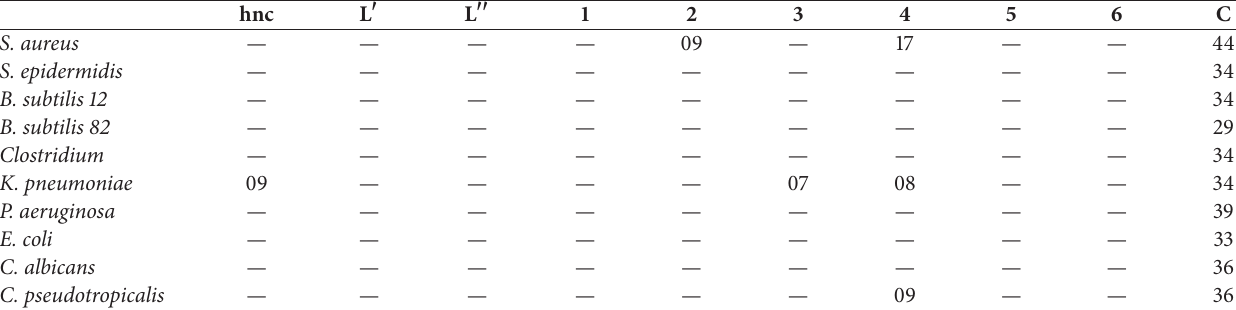
Table 3: Result of zone of antimicrobial inhibition (mm) for the ligands and